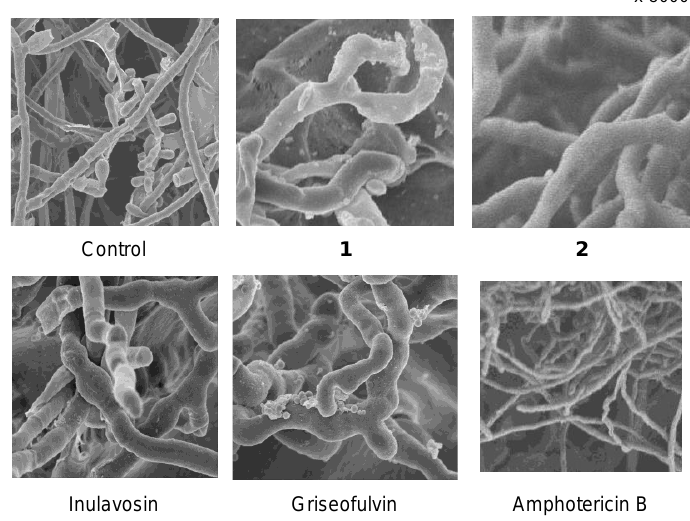
Figure 2. Scanning electron micrographs of compound-induced morphological change against T. rubrum .